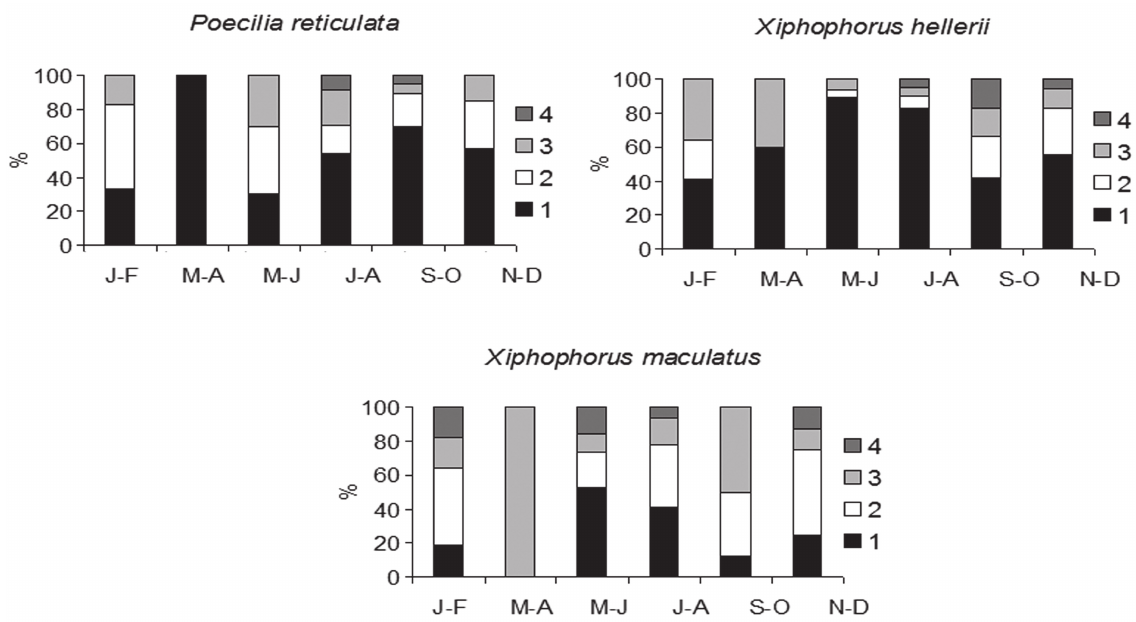
Fig. 2. Relative bimonthly frequency of developmental stages in ornamental non-native poeciliid females collected in Boa Vista Creek, 2003. Developmental stages: 1 Non-gravid, 2 Yolked ova, 3 Eyed embryos, 4 Mature